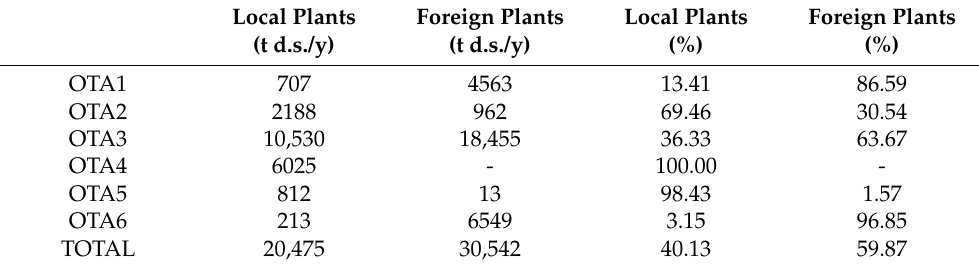
Table 3. Amounts of sewage sludge destined to local (internal) or foreign (external) plants for each OTAs.